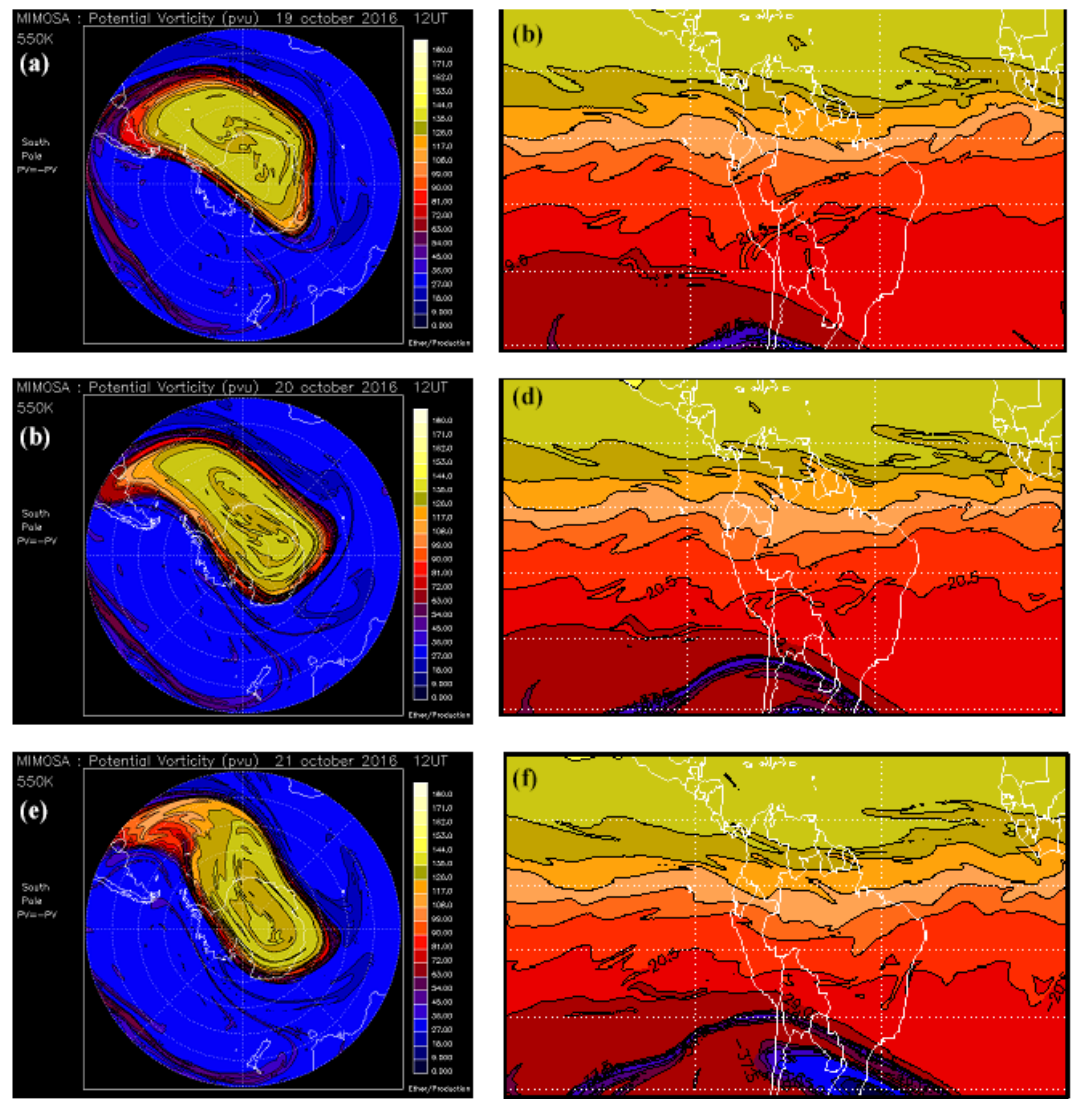
Figure 3. MIMOSA model for the analysis period showing the connection between the ozone hole and the study